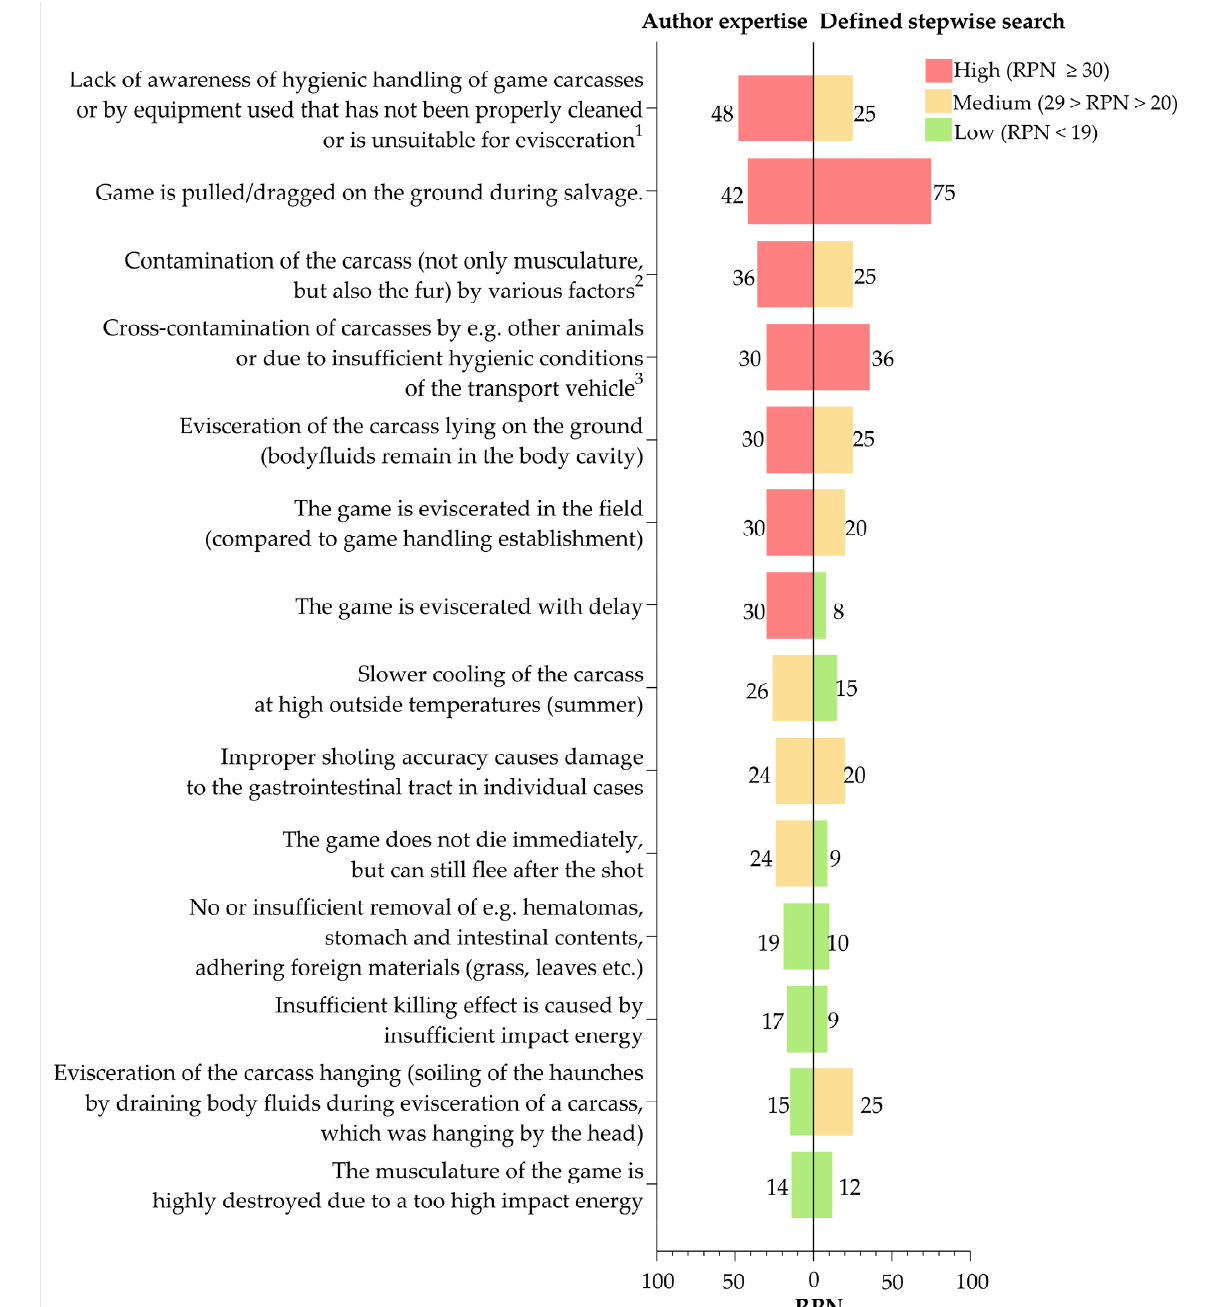
Figure 5. Risk Priority Numbers (RPNs) were compared using the authors’ expertise and a defined stepwise search. This search was conducted based on the results of this study, other published original research articles or when there was no published evidence on reported hunters’ experiences from the grey literature. The subjects are shown as presented in the (expert) assessment including the footnotes for further specification: (1) contamination of carcass by, e.g., unwashed hands in the absence of running water or improper handling with gloves or unclean or blunt knives; (2) e.g., rain, grass, leaves, surface water, etc. on the ground when the tarpaulin is not in use or when the stomach and intestinal tract of the game is damaged during evisceration and the contents contaminate the carcass; (3) e.g., stacking or too close placement of several killed animals on a transport vehicle that is contaminated with soil, leaves, blood residues from eviscerated